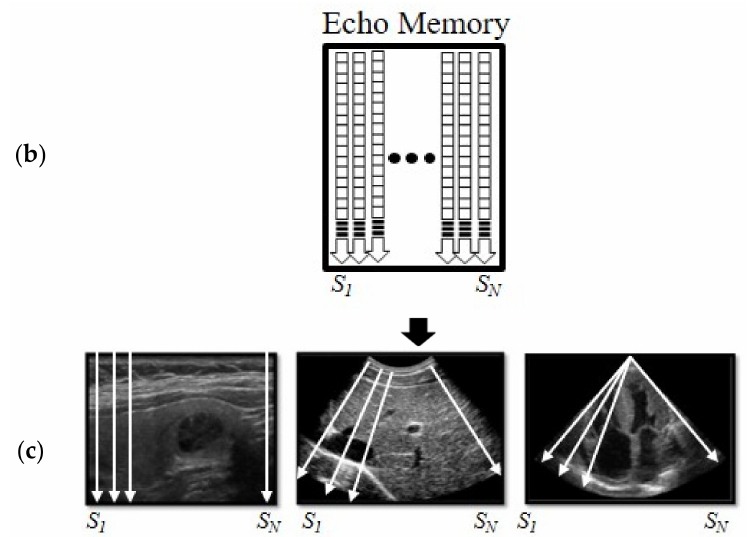
Figure 1. ( a ) N scanlines made of three transducers (left panel: linear array, center panel: convex array, right panel: sector phased array.) ( b ) Echo memory is stored to #scanlines by #samples , re- gardless of type of transducers. ( c ) I USI , digital scan-converted is reconstructed as an image with spatial information.